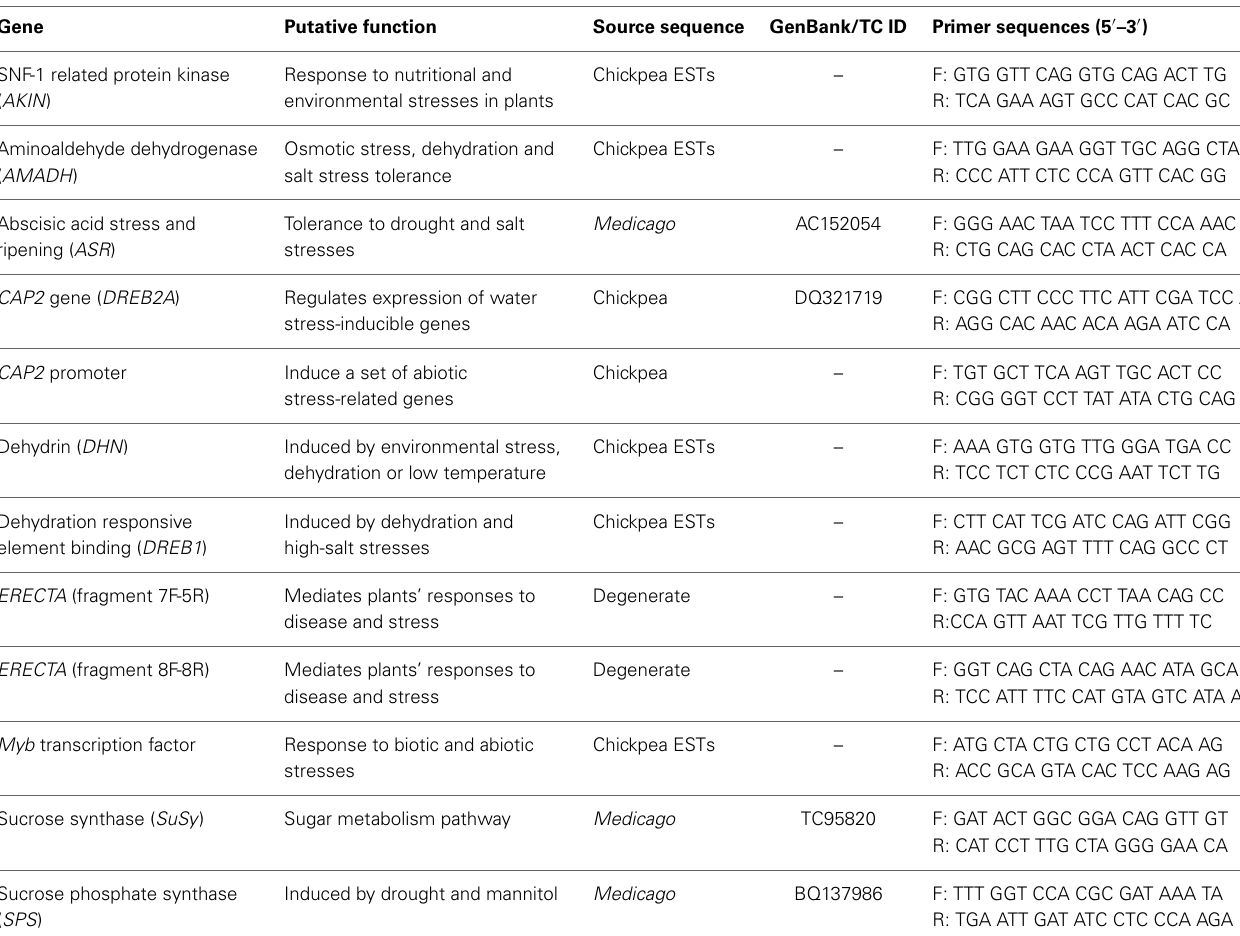
Table 1 | List of abiotic stress responsive genes and respective primers used for PCR amplification.